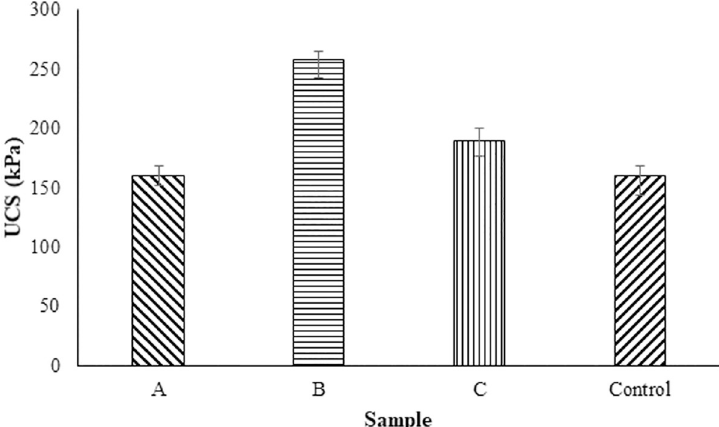
Fig 4. Unconfined compressive strength among indigenous bacteria found in the sand columns. A = Pseudomonas nitroreducens szh_asesj15; B = Bacillus sp. xjlu_herc15; C = Bacillus licheniformis adseedstjo15.